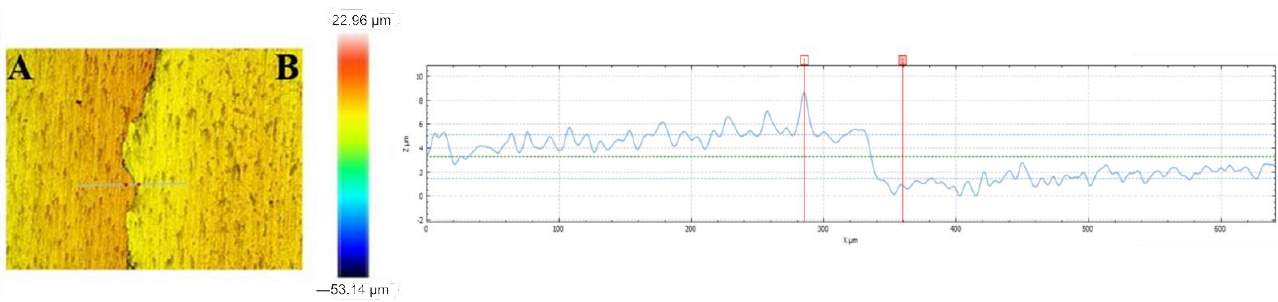
Figure 4. Profile of the VTMS coating ( A ) deposited on titanium alloy Ti13Nb13Zr in relation to the substrate without the coating ( B ), recorded with a SENSOFAR profilometer.